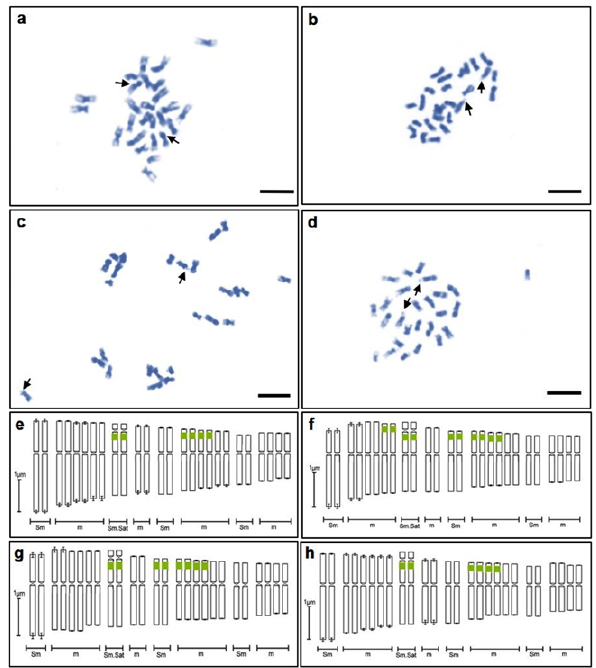
Figure 2. Panel A: EMA based giemsa stained mitotic metaphase plates of four Indian landraces of S. indicum showing 2n= 26 chro- mosomes. a) Black seeded til; b) Dark Brown seeded til; c) Light Brown seeded til; d) White seeded til. Arrows indicate secondary constricted chromosomes. Bar= 5 µm. Panel B: Comparative ideo- grams of the studied four landraces. Also showing positive CMA fluorescent band on respective chromosomes, Bar= 1